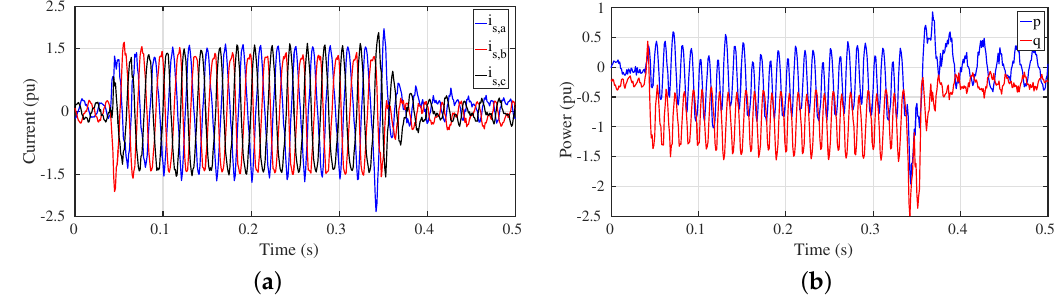
Figure 18. ( a ) Current waveforms and ( b ) instantaneous p and q waveforms for Scenario 3.